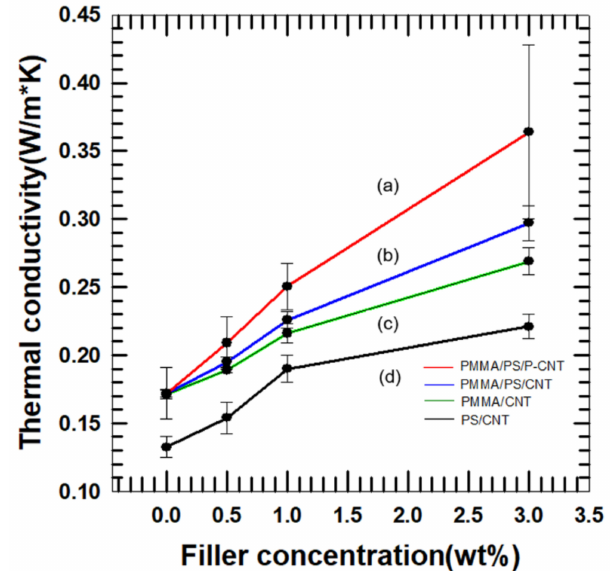
Figure 10. Thermal conductivity of composites. ( a ) PMMA / PS / PMMA– g –CNT, ( b ) PMMA / PS / CNT, ( c ) PMMA / CNT, and ( d ) PS /